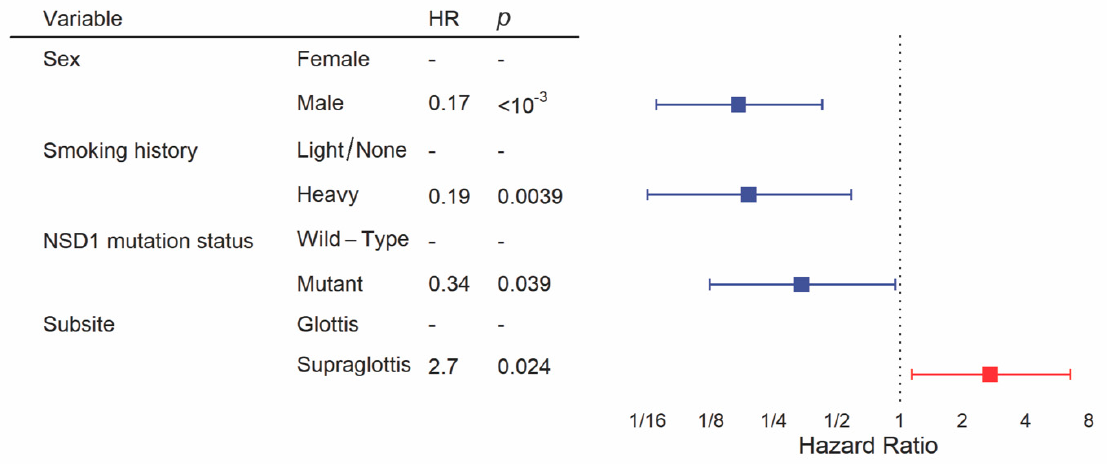
Figure 5. Multivariate analysis of overall survival between glottic and supraglottic LSCC. Backward selection was used to attain the multivariate model. All patients were included into the multivariate model but some were excluded by the algorithm if there were missing values for variables.